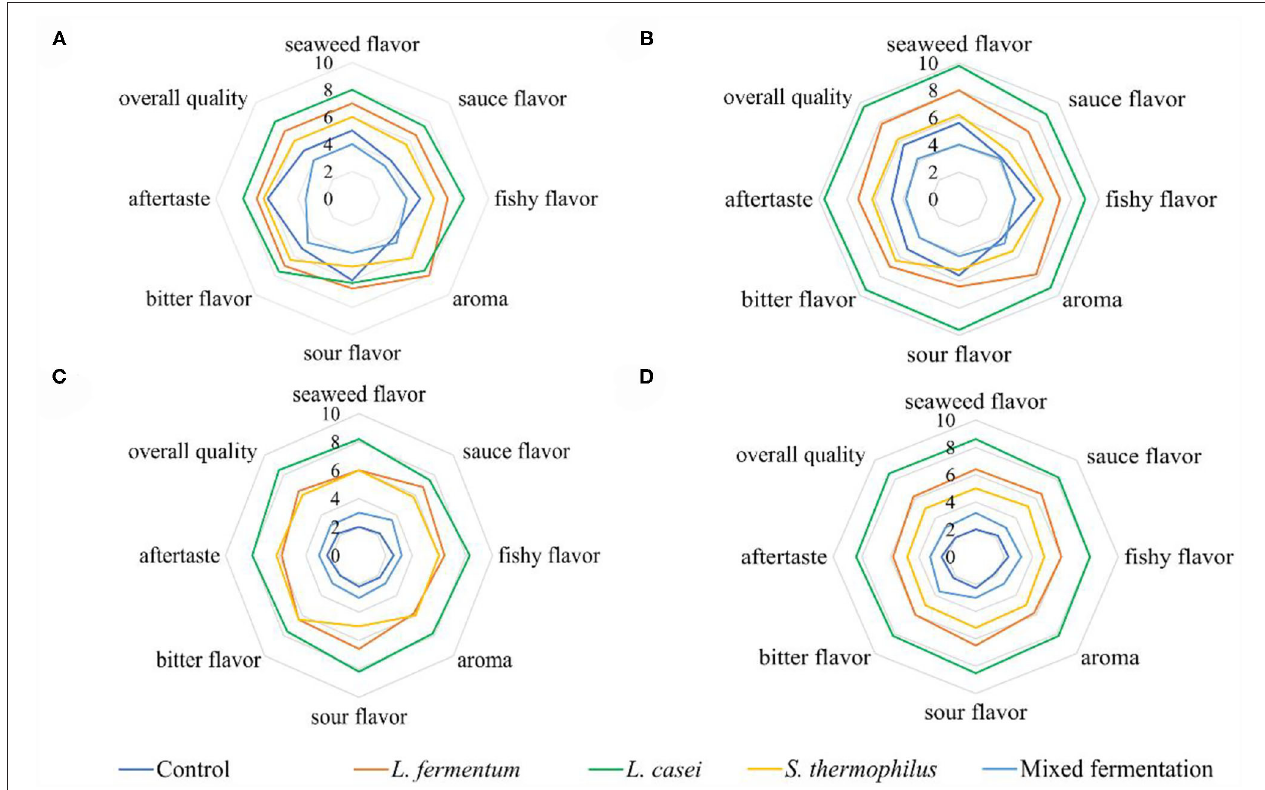
FIGURE 2 | Radiation map of sensory profile for fermented P. yezoensis sauces. (A) 3 days of fermentation, (B) 7 days of fermentation, (C) 14 days of fermentation, (D) 21 days of fermentation.